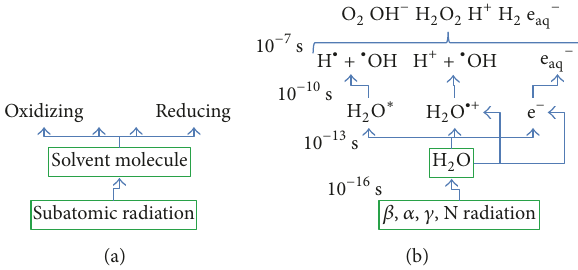
Figure 4: Irradiation of water by energetic subatomic particles. Based on Lousada et al.,